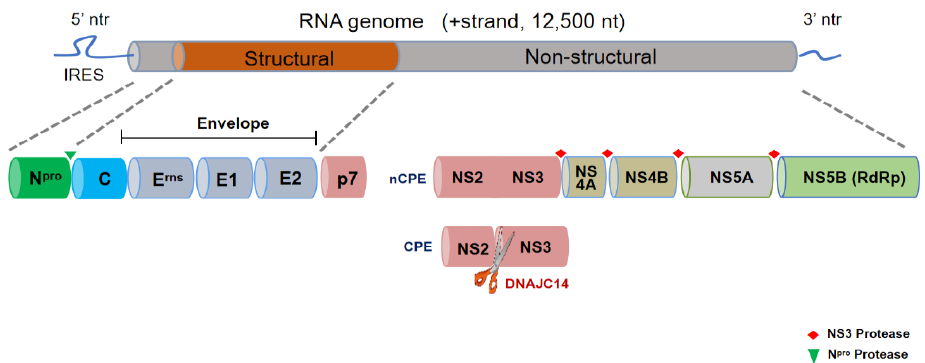
Figure 2. Graphical representation of the genome organization of BVDV. The BVDV genome is a single-stranded RNA of approximately 12.5 kilobases (kb) in size. The central panel shows the composition of the viral genome (the structural and non-structural proteins): four structural proteins (C, E rns , E1 and E2) and eight non-structural proteins (N pro , p7, NS2, NS3, NS4A, NS4B, NS5A and NS5B). The non-structural protein N pro encodes RNase; NS2 encodes a cysteine-auto-protease that cleaves NS2 and NS3, by which CP and NCP BVDV can be distinguished; NS3 encodes serine protease, RNA helicase and NTPase; NS5A encodes a protein that is a component of viral replicase; and NS5B is encodes RNA-dependent RNA polymerase.